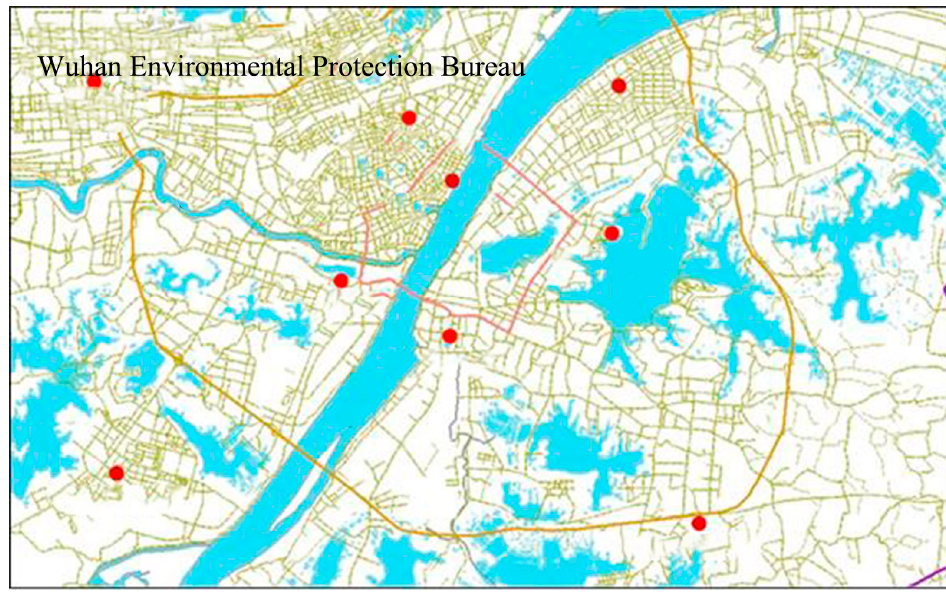
Figure 1. The map of air quality monitoring stations located in Wuhan City.